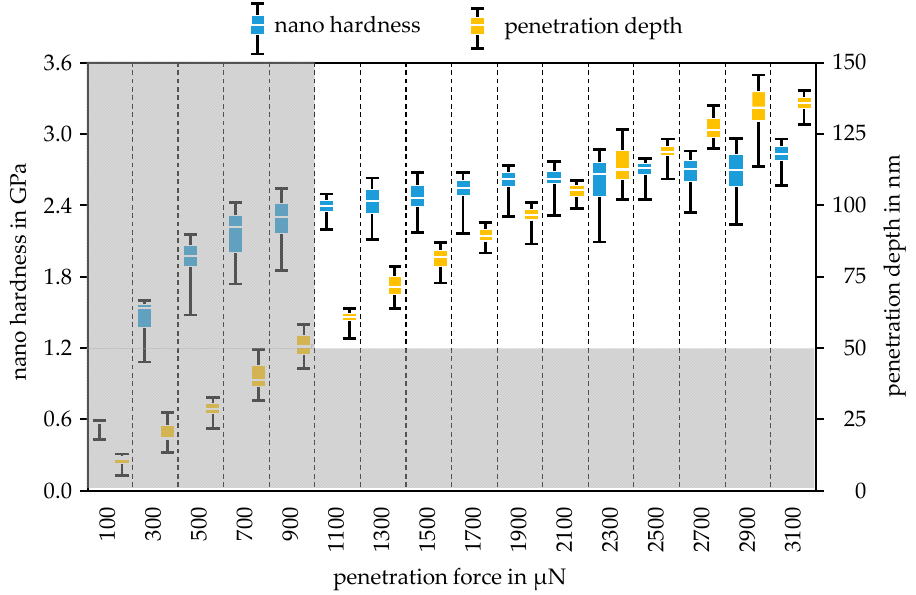
Figure 9. Development of the nano hardness and the penetration depth via the varied penetration forces for the MoO 3 ‐ coating with minimum and maximum values.